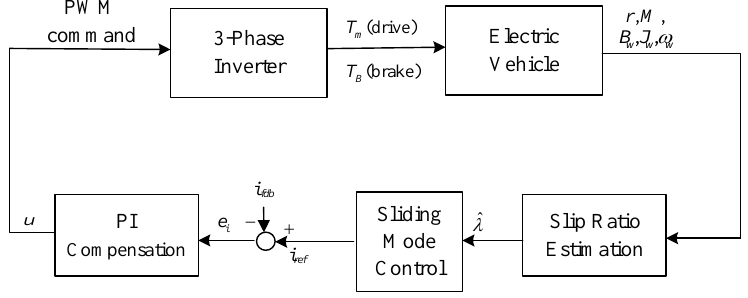
Figure 5. Architecture of the braking control system.